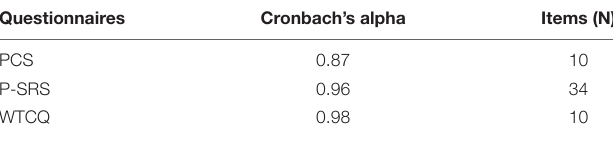
TABLE 2 | The reliability of perceived caring scale (PCS), professor-student rapport scale (P-SRS), and willingness to communicate questionnaire (WTCQ).